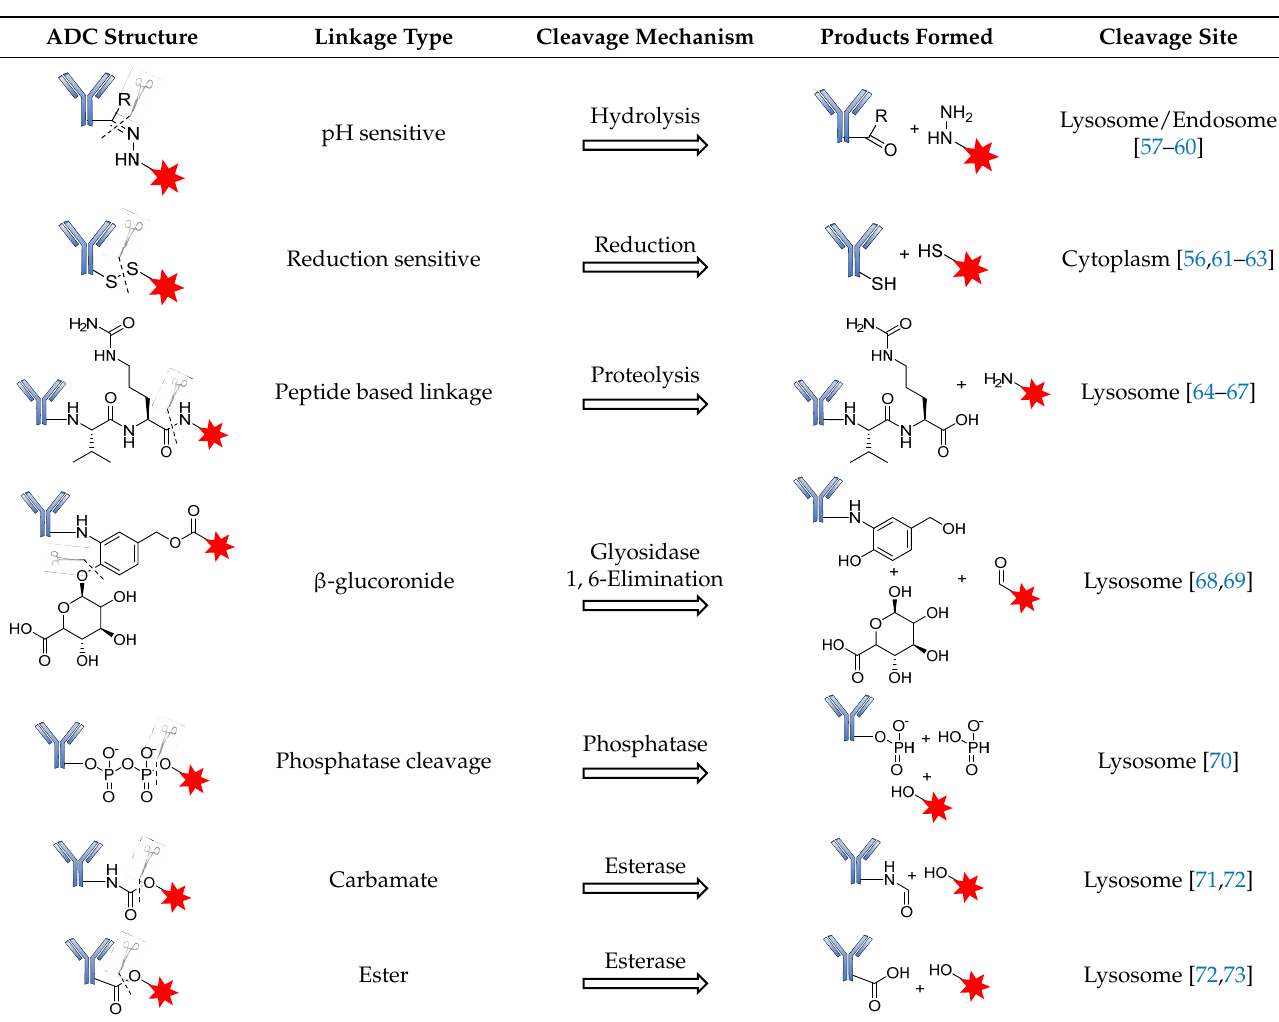
Table 1. A selection of cleavable linkage types, their structures, cleavage conditions, cleavage products, and site of cleavage.